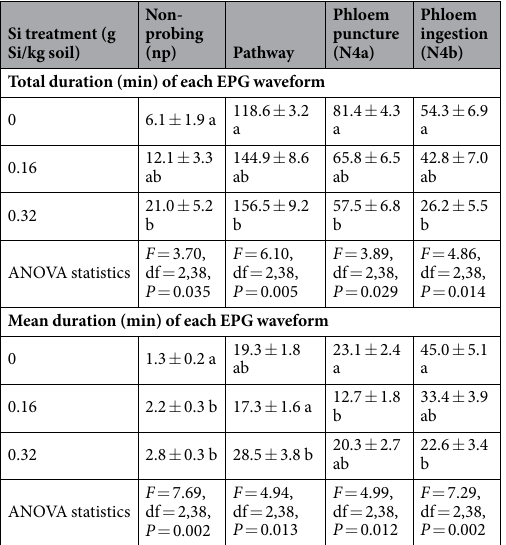
Table 1. Feeding behaviors of Nilaparvata lugens recorded by EPG on rice plants amended with Si or not over a 6-h recording period. Data are expressed as mean ± SE. Data in a column followed by different letters are significantly different (Tukey’s multiple range test, P = 0.05). The data are averages of 12–14 recordings per